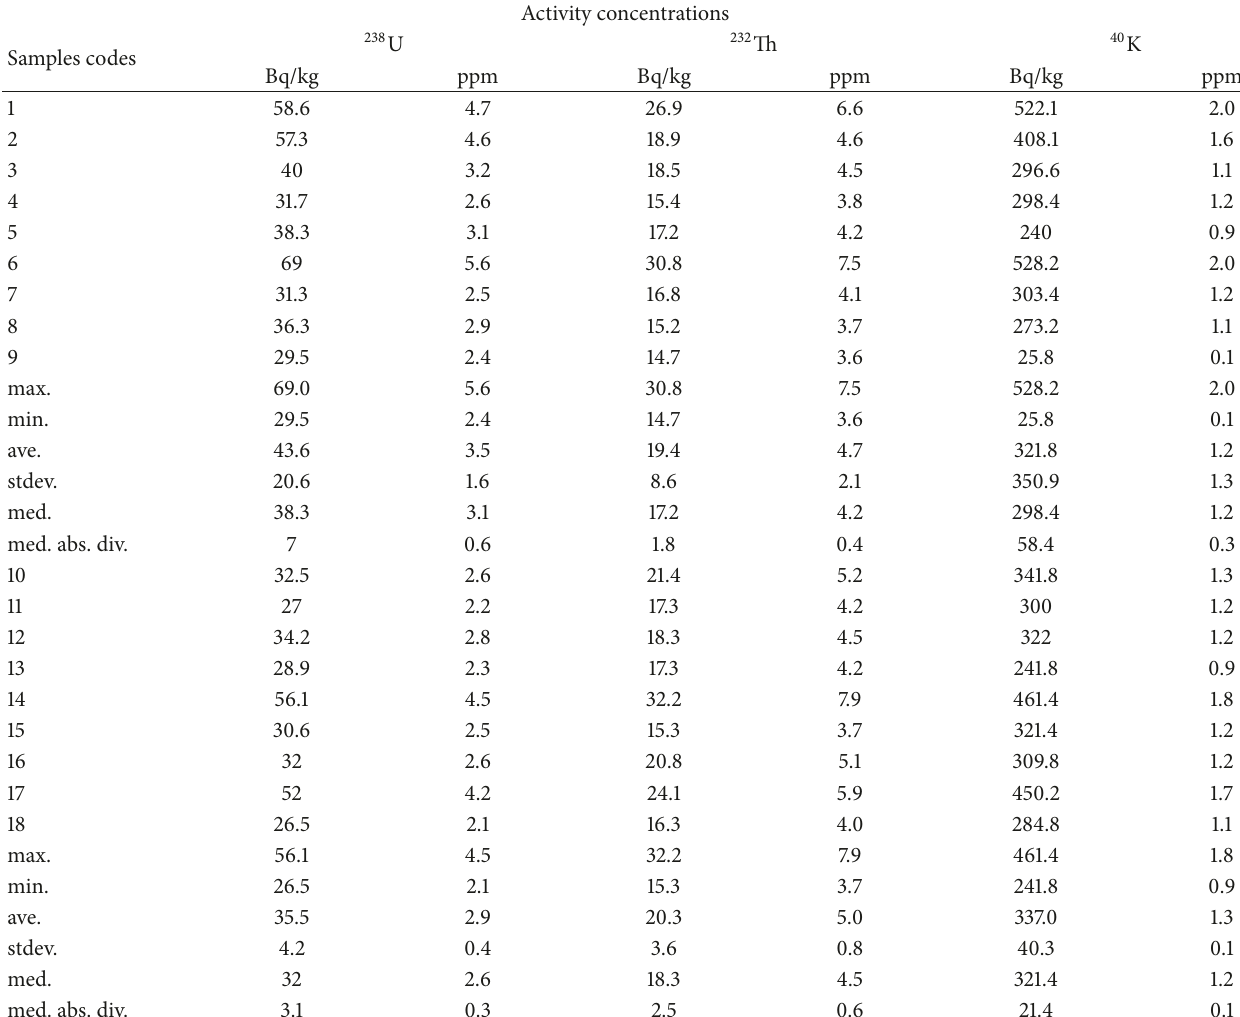
Table 3: 238 U, 232 Th, 40 K activities in Bq/kg [7] and the estimated values in ppm using 𝛾 -ray spectroscopy. Activity concentrations